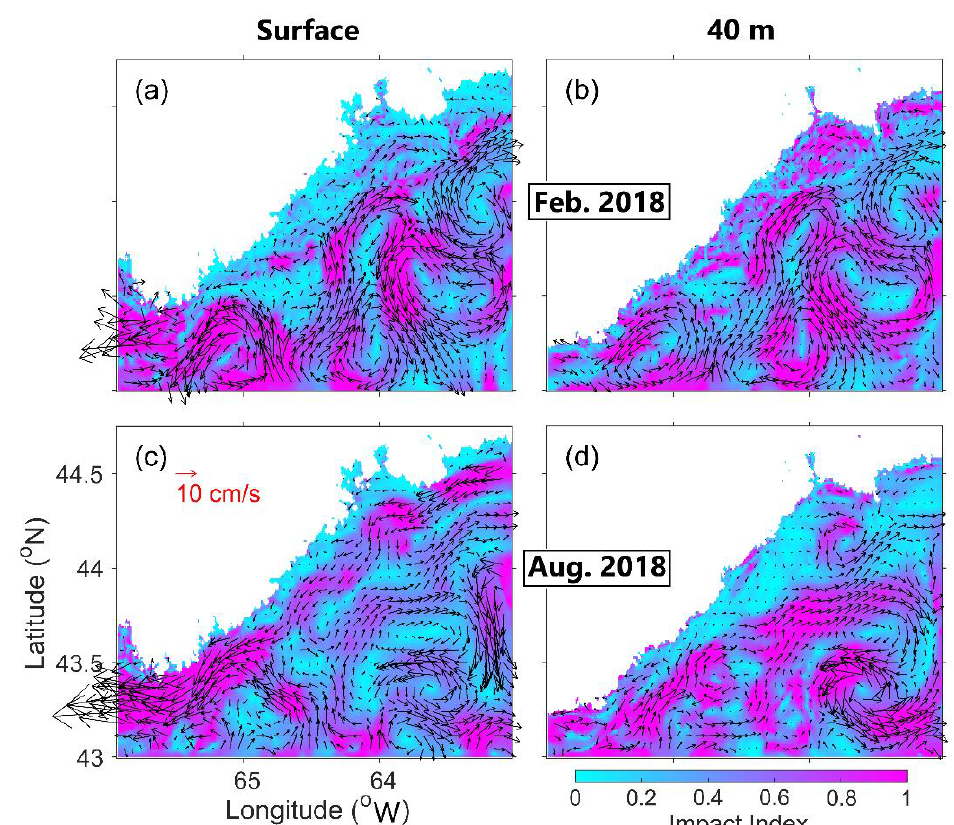
Figure 18. Differences in the monthly-mean ( a , c ) surface and ( b , d ) sub-surface (40 m) currents (vector fields) in ( a , b ) February and ( c , d ) August 2018 between cases CR and NT (calculated based on the L3 model results). For clarity, velocity vectors are plotted at every 7th model grid point. The color image indicates the associated impact index calculated using the method by Wang et al. [9].